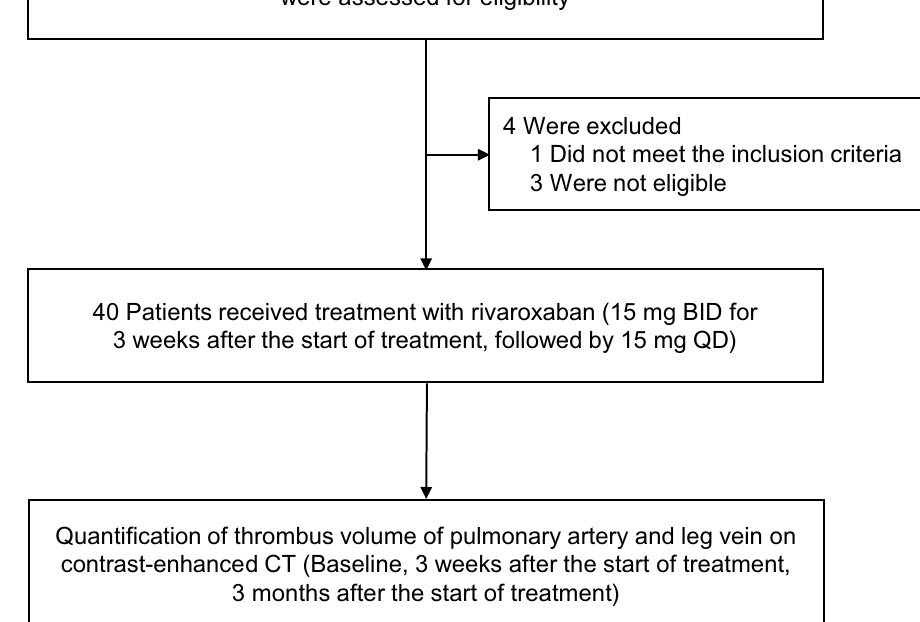
Figure 1. Patient selection flowchart. BID, twice a day; CT, computed tomography; QD, once a day; VTE, venous